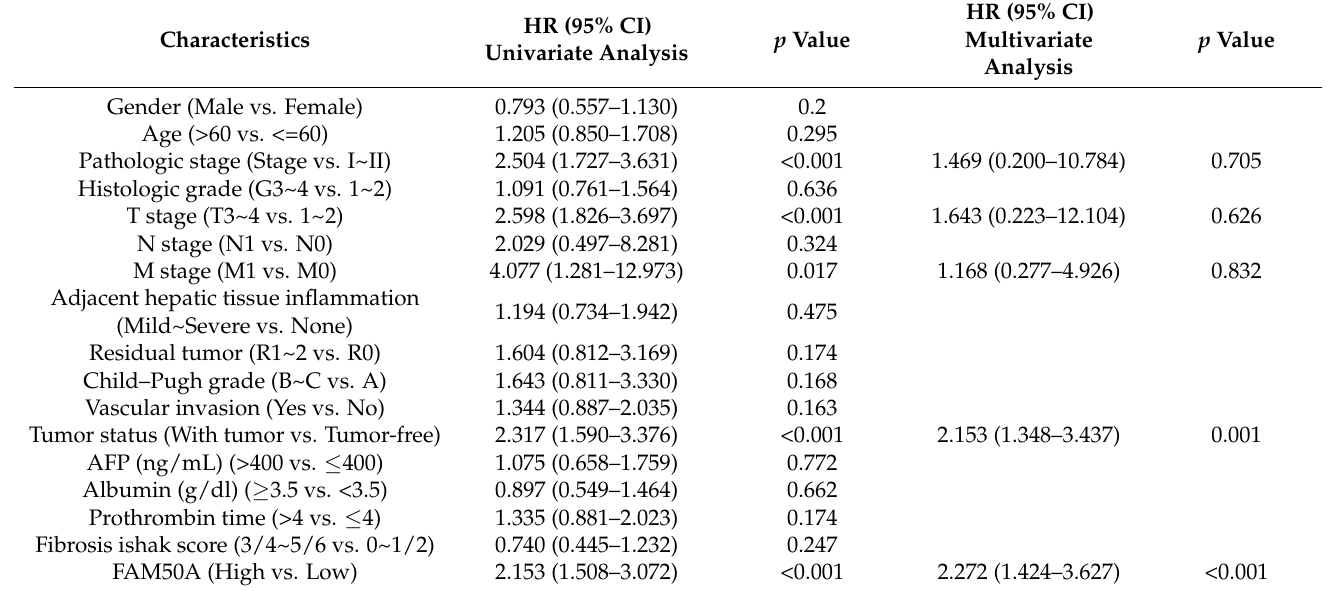
Table 1. Univariate and multivariate COX regression analysis of OS in HCC patients induced by